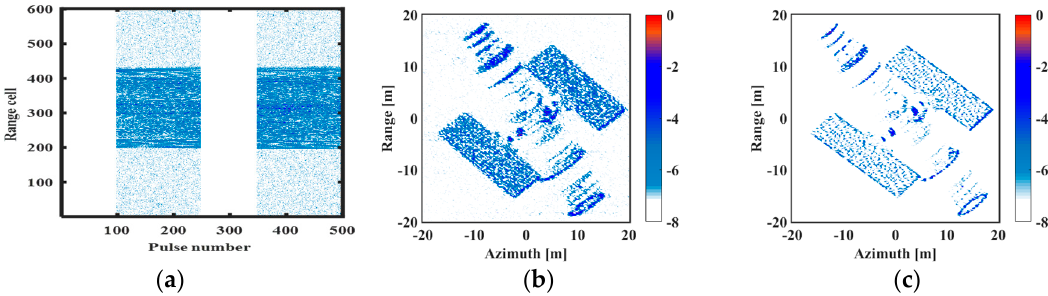
Figure 15. Range profiles and imaging results with GMS of 300 pulses: ( a ) Range profiles; ( b ) Imaging result of algorithm in [23]; ( c ) Imaging result of the proposed algorithm.